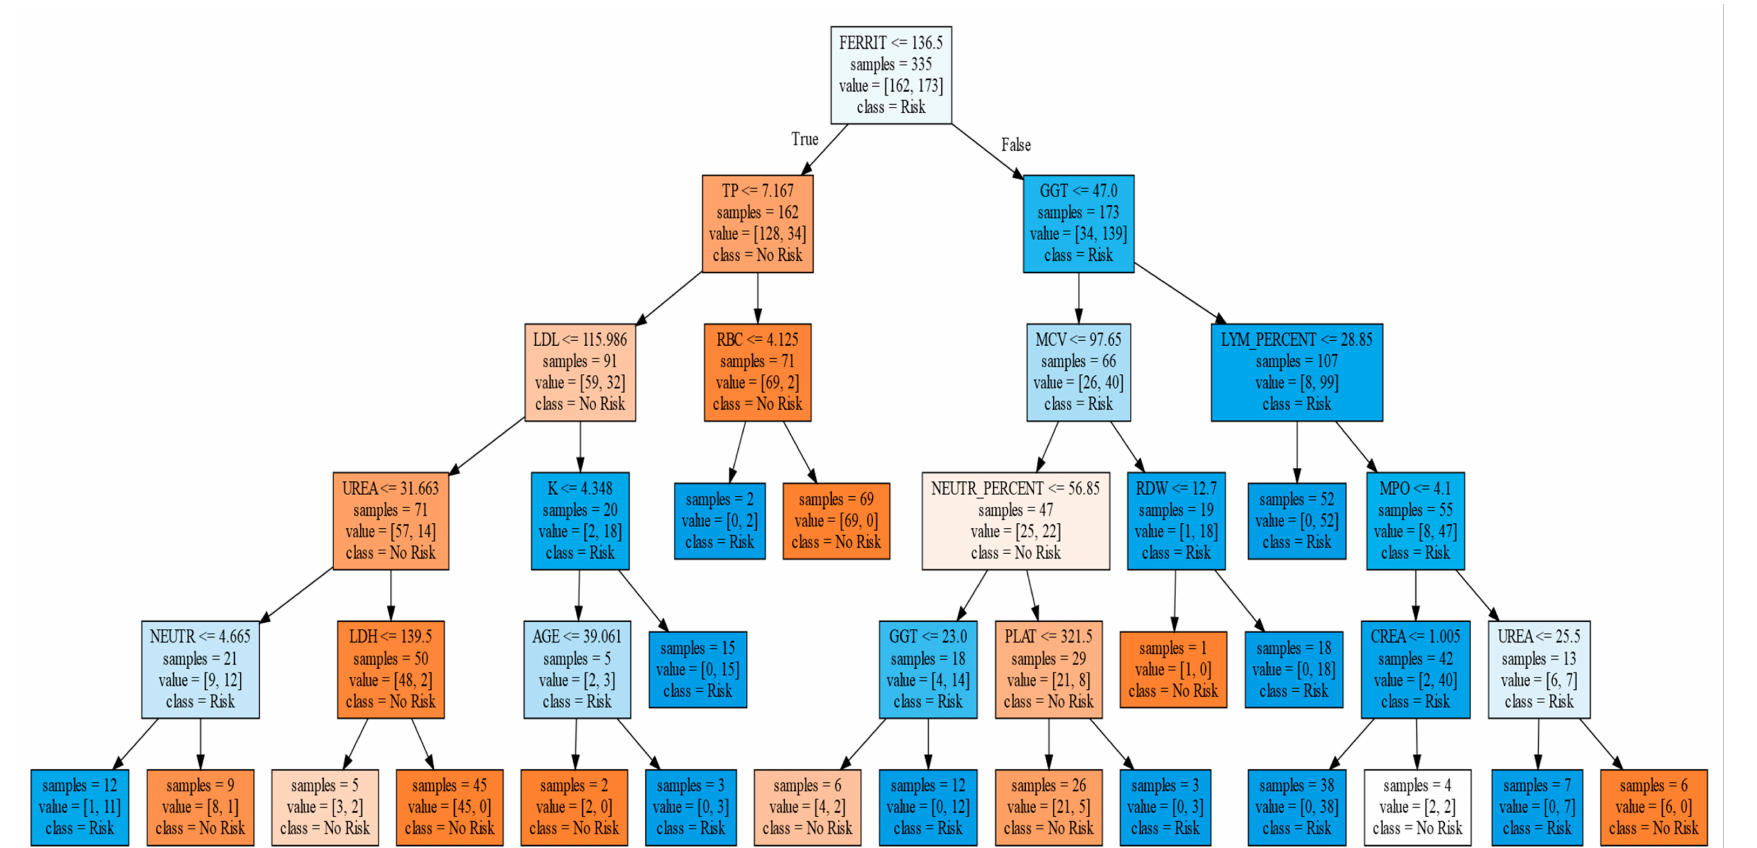
Figure 4. Classification tree. In that figure, the square brackets are not bibliographic references. It shows the generated tree, whose initial root node is with the variable ferritin, and depending on whether its value is greater or less than 136.5, it continues with total proteins (TP), or gamma-glutamyl transferase (GGT), and later, depending on the value of these, it continues toward different variables, to finally reach the different sheets, in the lower part, that predict whether the participant is at risk or not at risk, with respect to risky alcohol